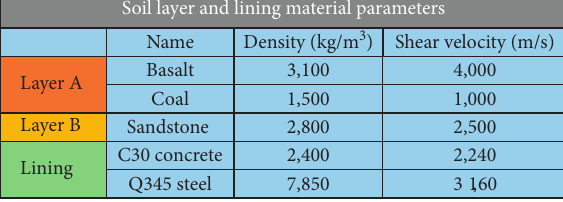
Figure 2: Parameters of soil layer and lining material of the composite strata model.